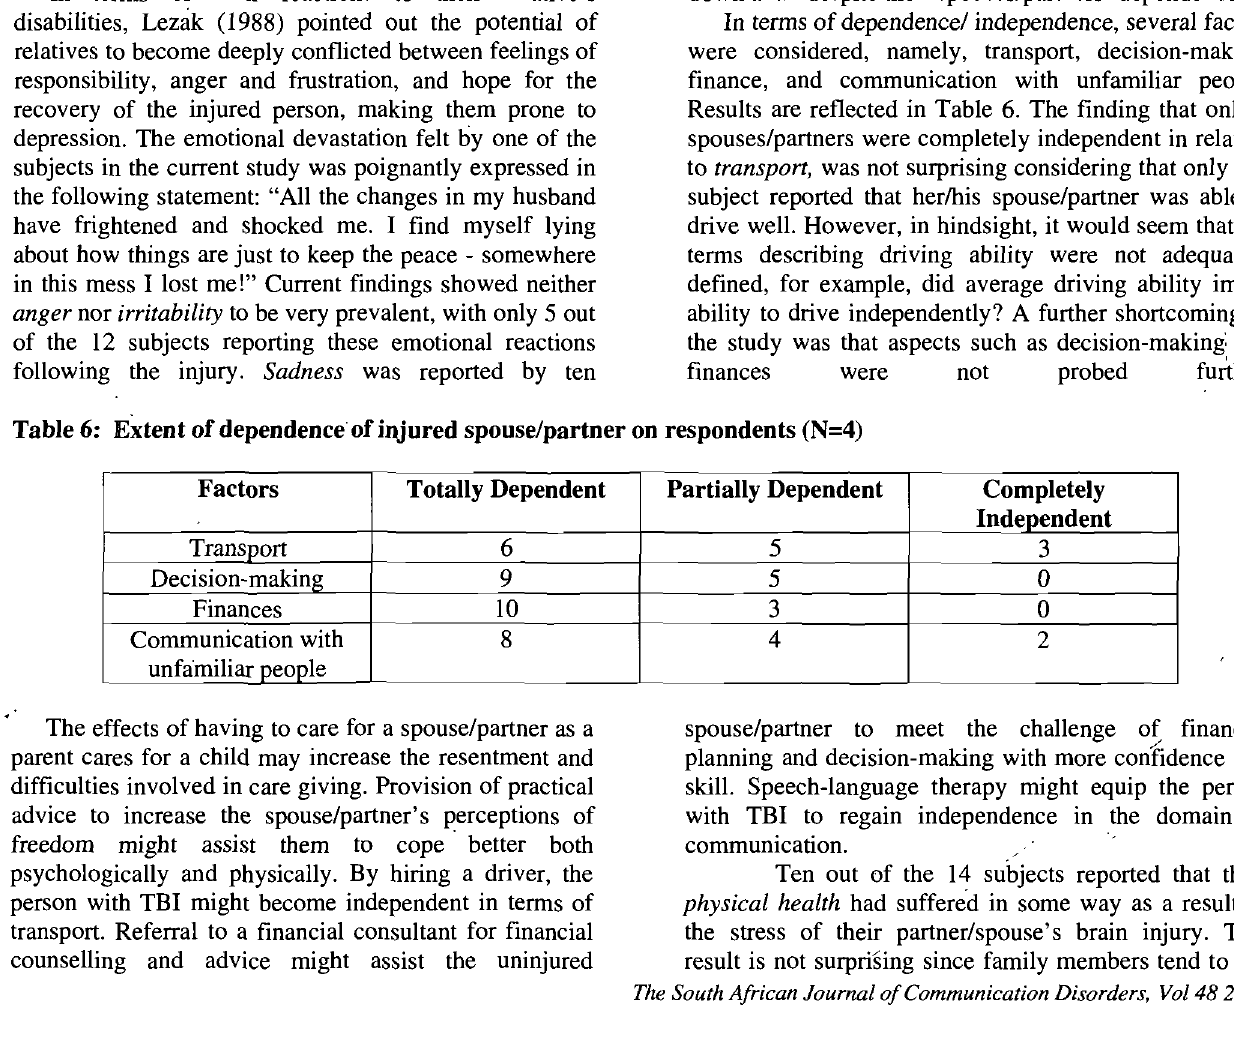
Table 6: Extent of dependence of injured spouse/partner on respondents